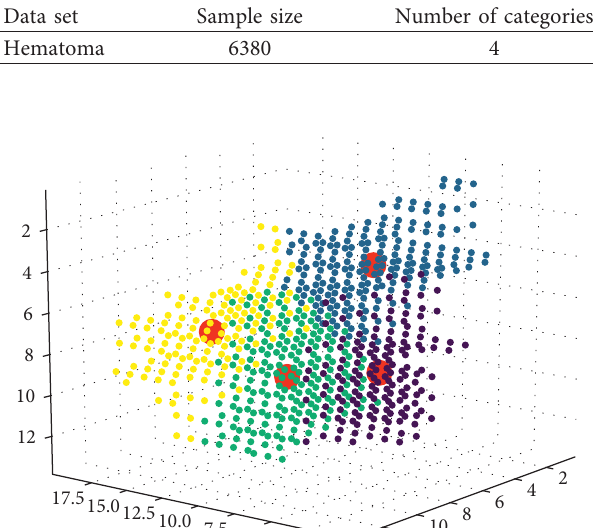
Table 2: Internal data set of hematoma.